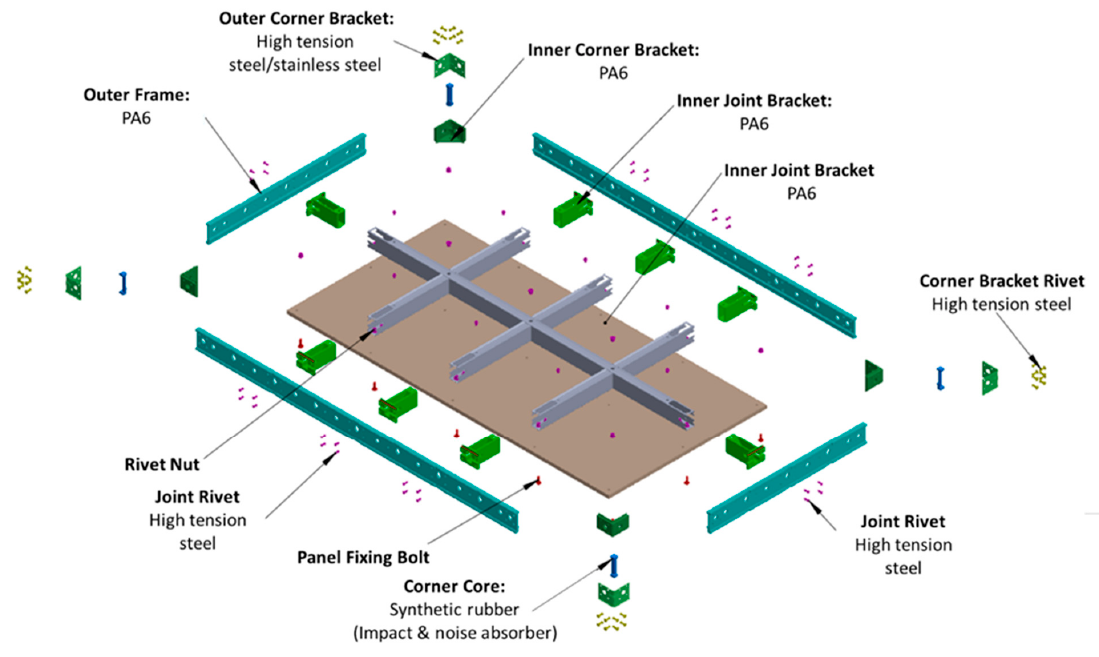
Figure 6. Detailed configuration of the composite system form (CSF).